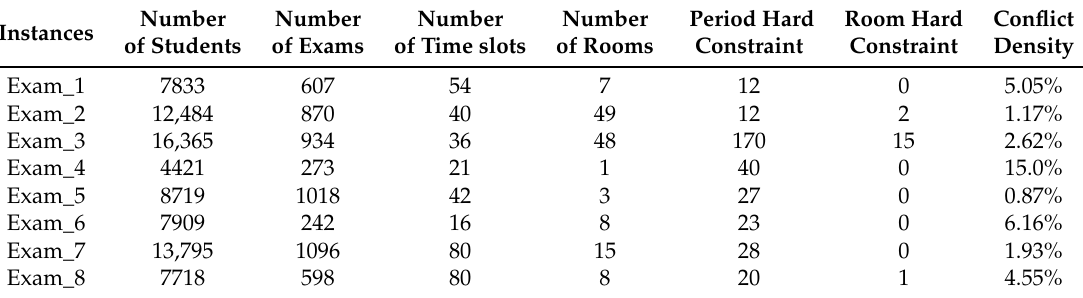
Table 2. ITC2007 Exam